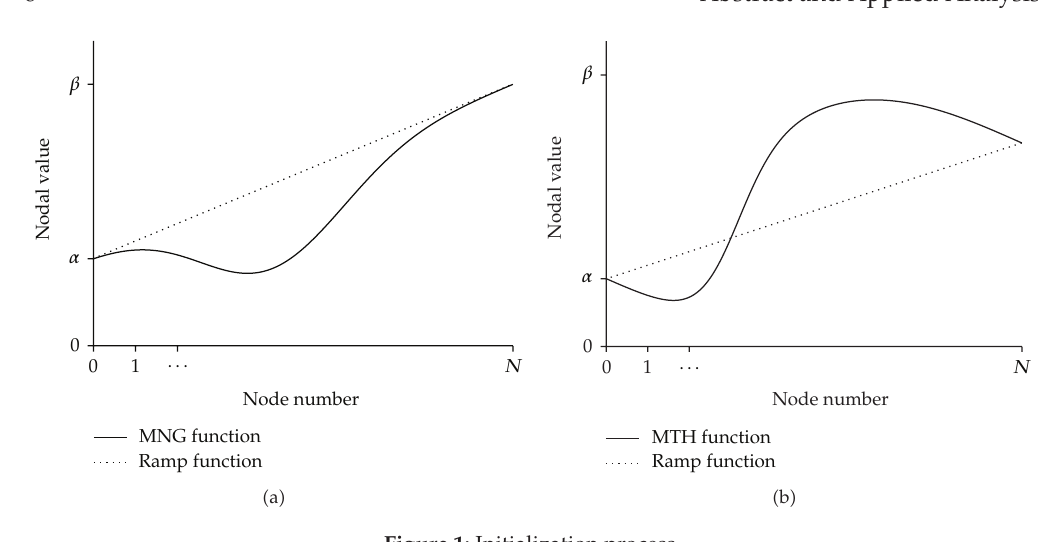
Figure 1: Initialization